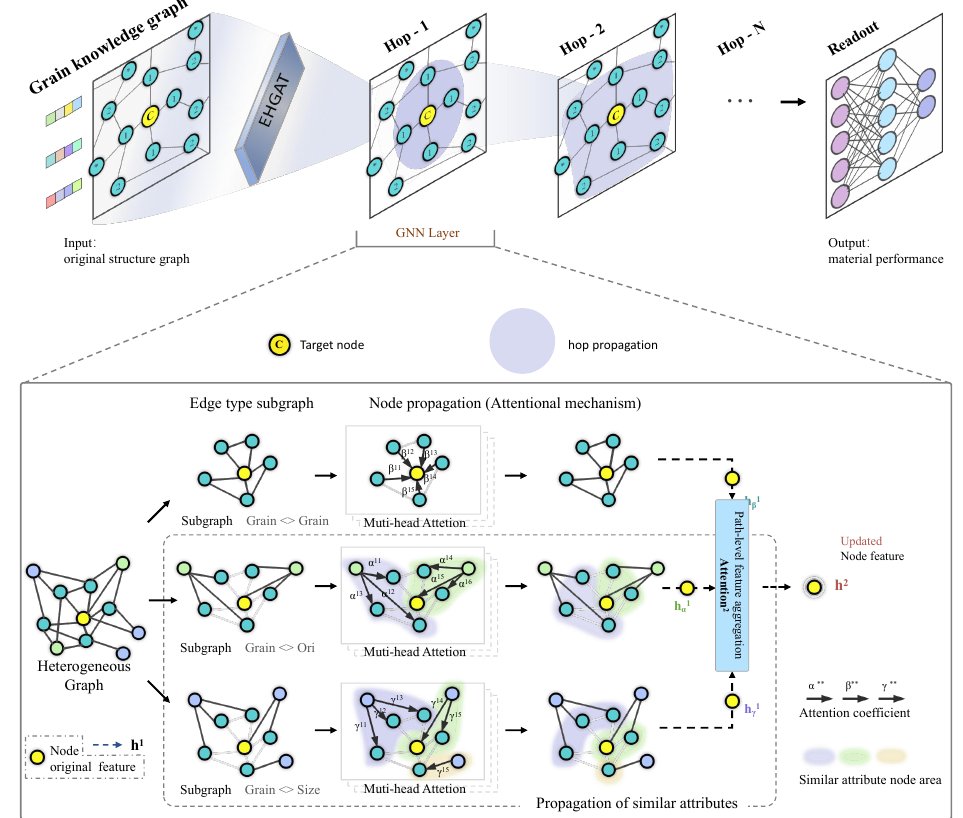
Figure 9. Grain graph convolutional prediction